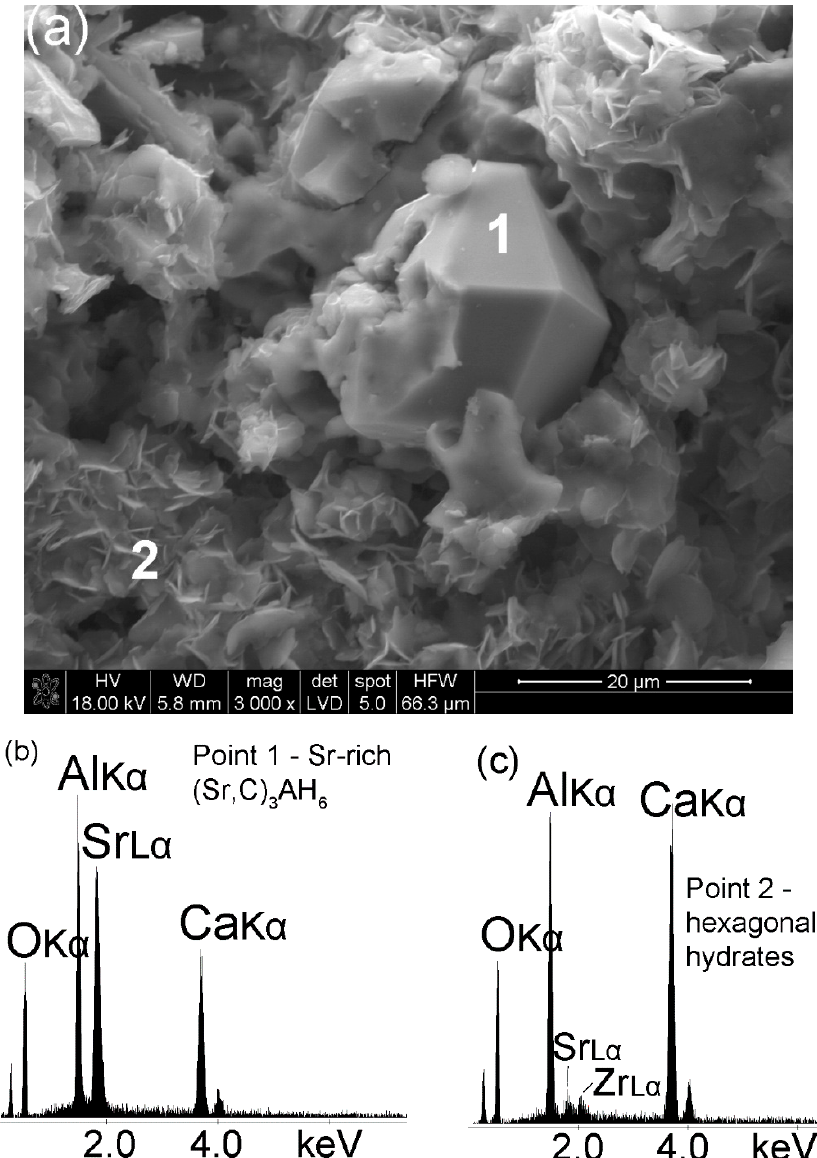
Figure 5. SEM image of the hydrated Sr 1.25 Ca 5.75 ZrAl 6 O 18 cement (Sample A) at the age of 24 h ( a ). Spot 1–2 EDS analysis; ( b , c ) EDS spectra of the sample in the microarea 1 (Sr-rich (Sr,C) 3 AH 6 ) and 2 (hexagonal calcium aluminate hydrates), respectively.